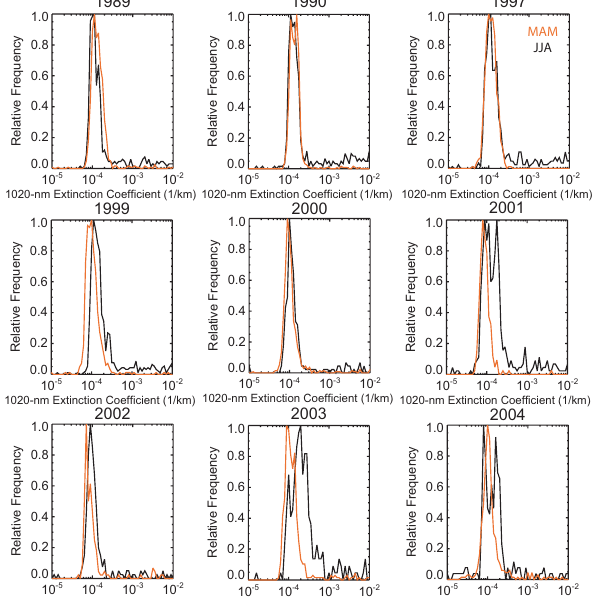
Fig. 12. Scatter plots of SAGE II measure 525–1020nm aerosol extinction coefficient ratio to aerosol 1020nm extinction coefficient density for selected years between 1989 and 2005. Data from MAM is shown in red while data for JJA is shown in